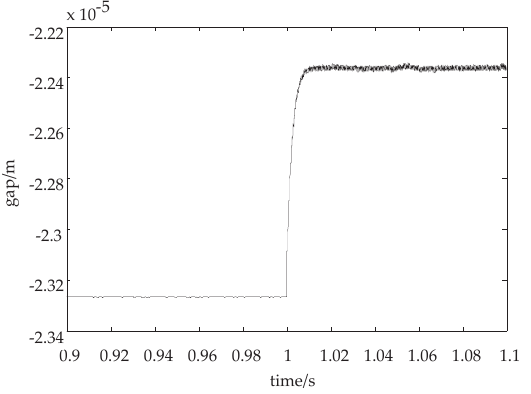
Figure 5. The suspension displacement curve with the adaptive control parameters while the load mass